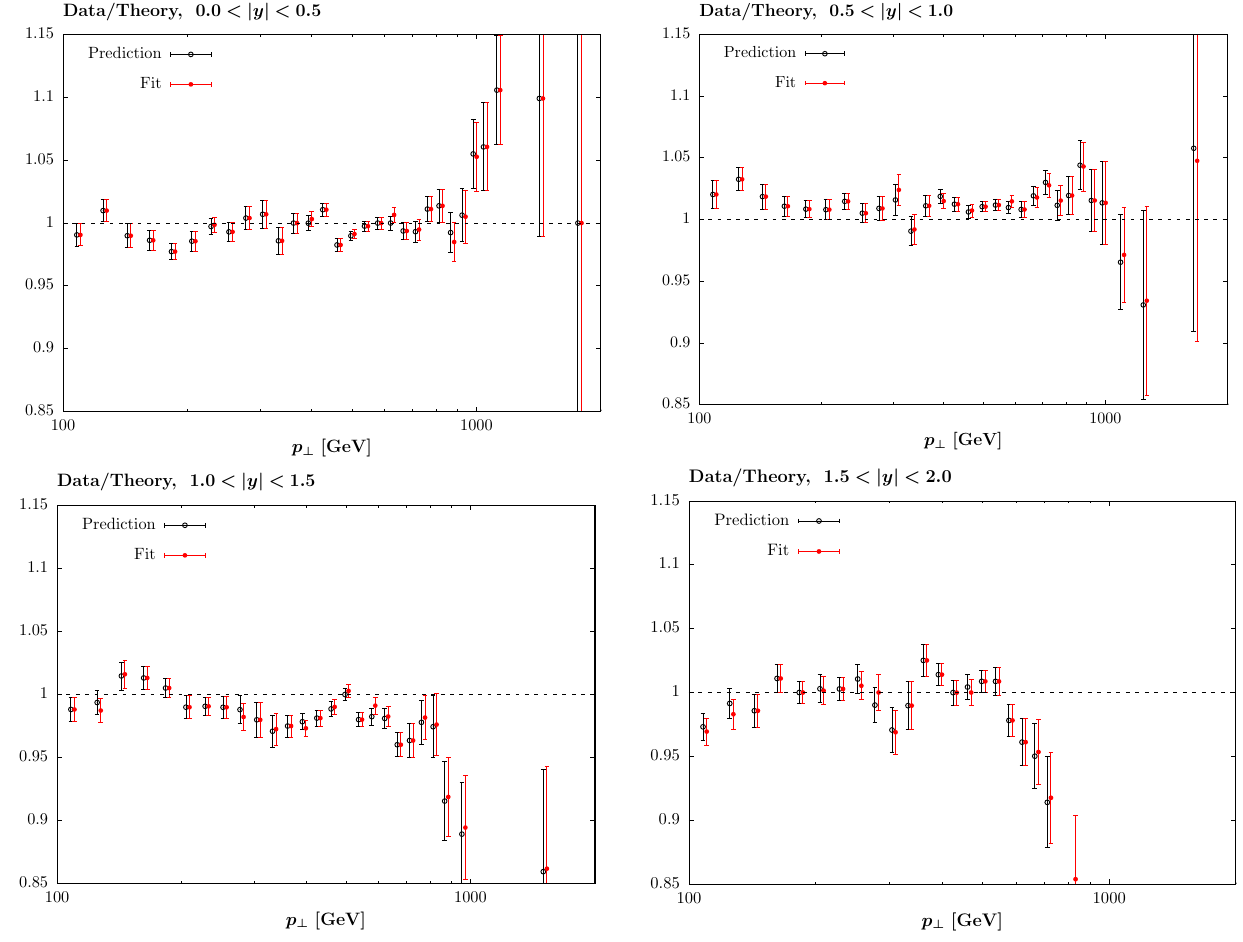
Fig. 2 Comparison of NLO prediction and fit to ATLAS jet data [23] for first four rapidity bins. Data/theory is plotted, with the data already shifted by the systematic uncertainties in order to achieve the best description. The displayed errors are purely